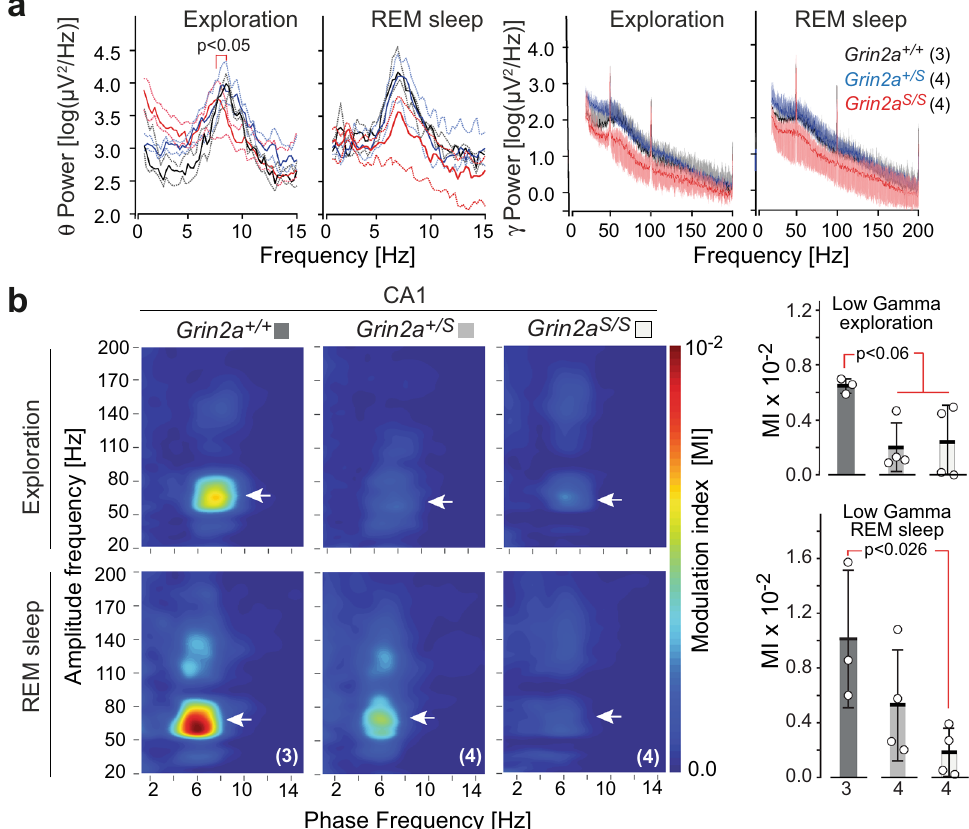
Fig. 6 Adult GluN2A(N615S) mutant mice express altered hippocampal oscillations during wakefulness and REM sleep. a (left) Peak frequencies during exploration and rapid eye movement (REM) sleep for theta (0 – 15 Hz, left diagrams) and gamma oscillations (15 – 200 Hz, right diagrams) in all genotypes. During exploration, the average theta range peak frequencies were at 8.61 ± 0.07 and 8.75 ± 0.28 Hz for Grin2a + / + mice and Grin2a + /S mice, respectively. In Grin2a S/S mice the theta range peak frequency was signi fi cantly slower, measuring 7.43 ± 0.24 Hz (Kruskal Wallis test, p = 0.0159). During REM sleep the average frequency ranges of Grin2a + / + and Grin2a + /S mice were around 7.00 ± 0.20 Hz whereas Grin2a S/S mice had a lower but not signi fi cantly different range 6.71 ± 0.22 Hz. a (right) No signi fi cant differences on the low and high gamma frequency bands — ranges between 20 – 100 Hz and 100 – 200 Hz, respectively 111 — could be detected between genotypes, neither during exploration nor in REM sleep. The number of mice used in this experiment are given with the name of the genotypes. b (left) Grin2a S/S and Grin2a + /S mice show reduced theta-gamma phase – amplitude coupling as determined by the modulation index (MI) in the low gamma component in CA1 (white arrowheads) during awake and REM sleep states. b (right) For Grin2a S/S the MI value dropped signi fi cantly during exploration and REM sleep although the MI reduction reached signi fi cance only during exploration (one-way ANOVA, Kruskal – Wallis test). Numbers below bars of bar graphs indicate the number of animals. Error bars represent mean ±